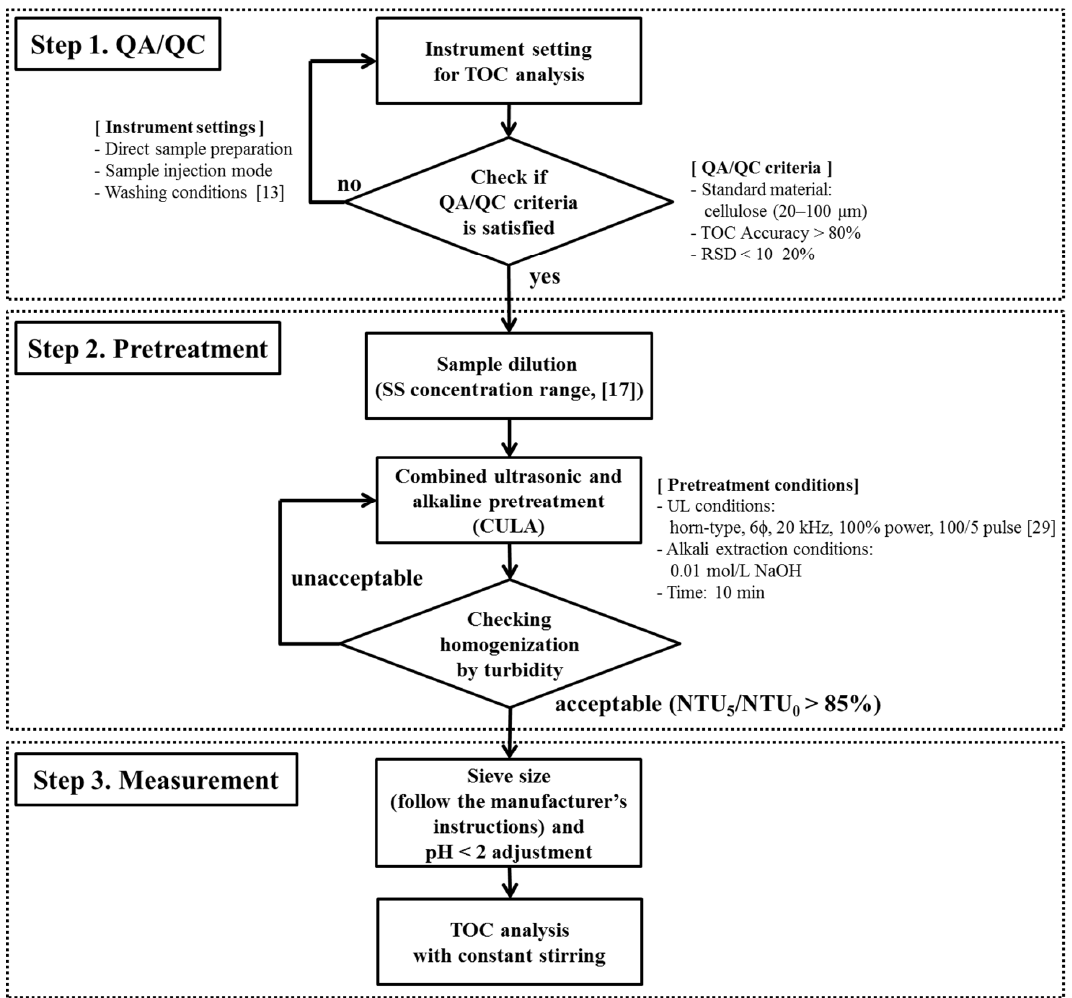
Figure 4. Proposed procedure for total organic carbon (TOC) analysis of water samples containing suspended solids (SS). RSD — relative standard deviation.